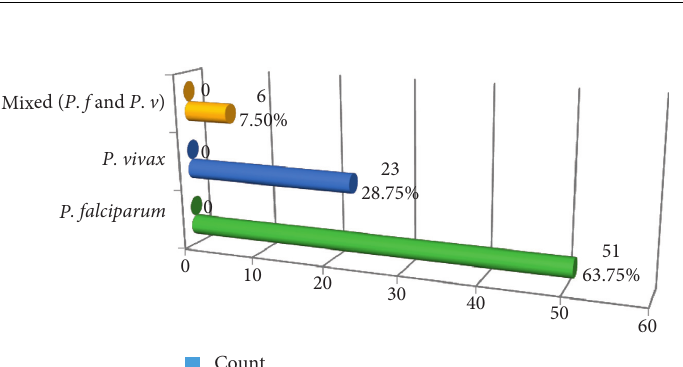
Table 2: Comparison of Care Start ™ malaria RDT with microscopy for the identification of malaria species, Arba Minch, 2015. Malaria species detected by RDT